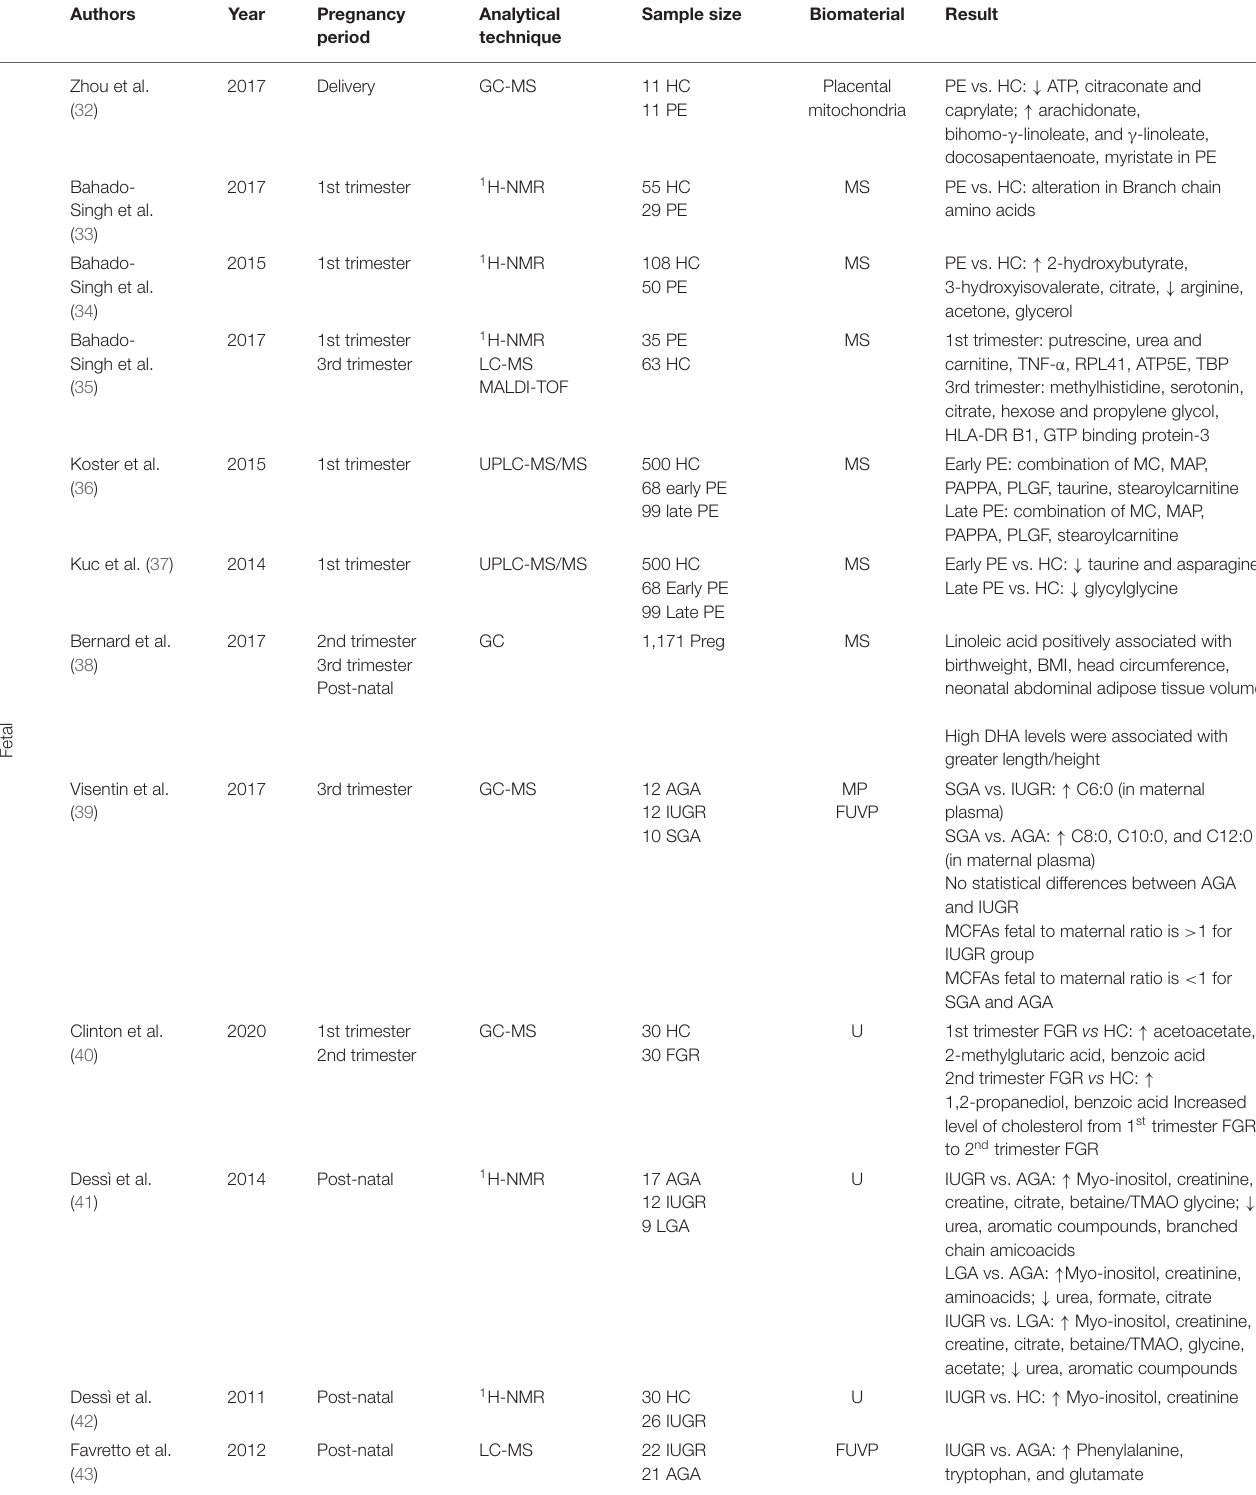
PE vs. HC: alteration in Branch chain amino acids